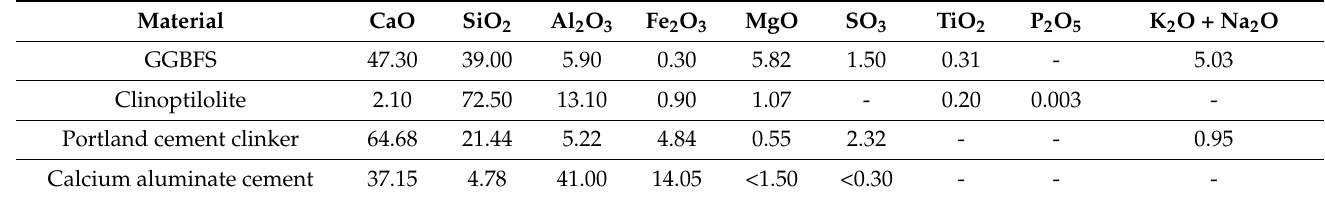
Table 1. Chemical composition of dry constituents (% by